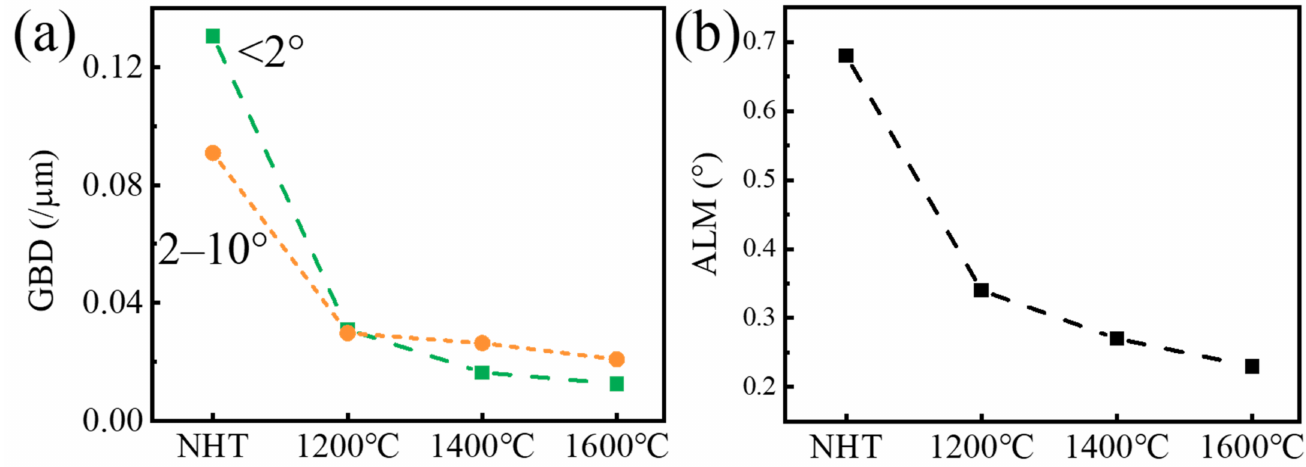
Figure 12. ( a ) Grain boundary densities and ( b ) Average local misorientation after post heat treatments. The deformation-induced dislocation could be hindered by oxygen and nitrogen im- purities, small-angle grain boundaries, and ALM during the tensile test. Dislocations tend to pile up at high-density small angle grain boundaries inside grains, leading to local stress concentrations. When the deformation stress exceeds the binding strength, a transgranu- lar fracture could occur (Figure 8c,d). Transgranular cleavage fractures transformed into ductile dimple fractures with an obvious necking phenomenon after the vacuum heat treatment at 1600 ◦ C (Figure 13a,b). This is because the decrease in GBD and ALM could lead to a decrease in dislocation slip resistance and an increase in the dislocation mean free path. Dislocations tend to pile up in oxygen impurities. When the deformation stress ex- ceeds the binding strength of oxygen impurities, voids aggregate, and then ductile dimple fracture